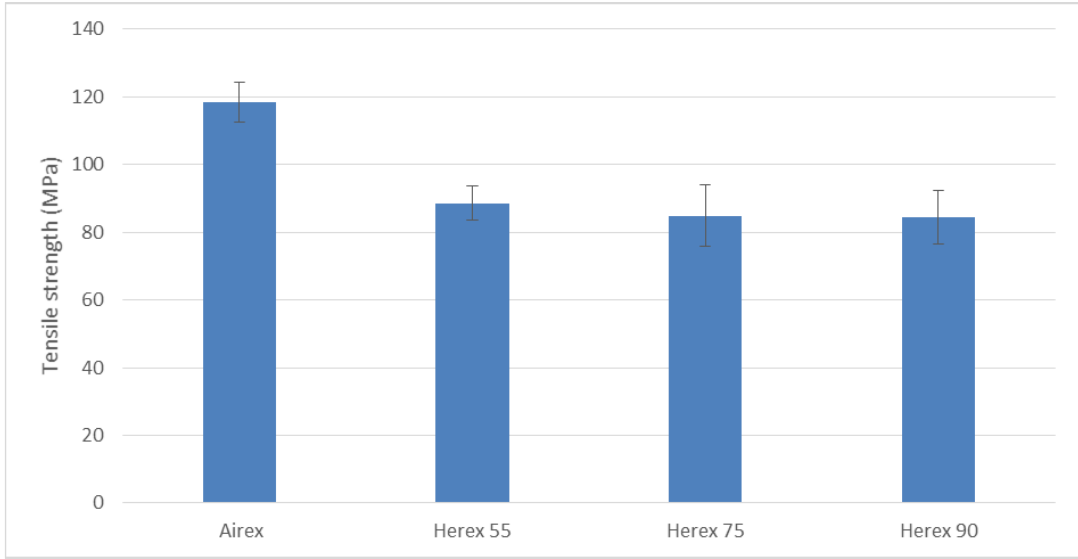
Figure 20. Tensile strength of the tested composites.